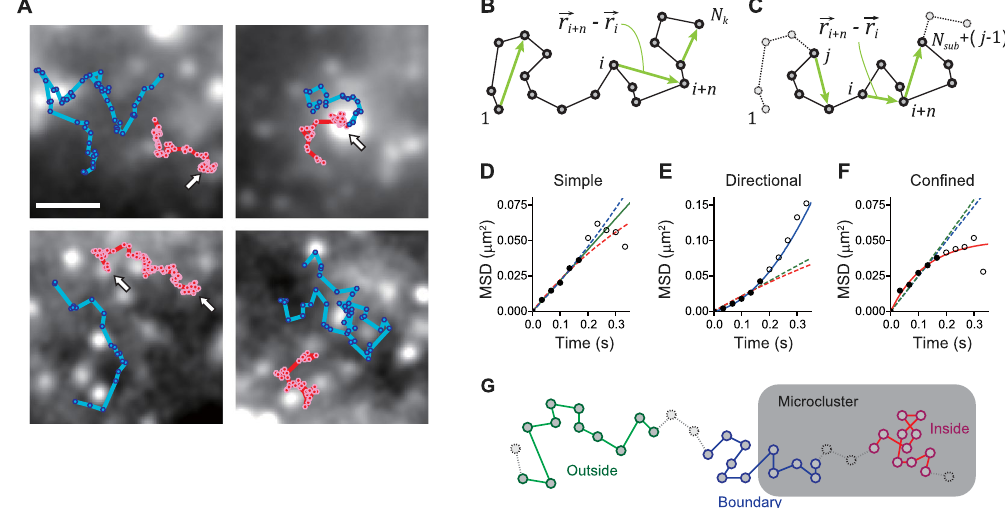
Figure 3. Schematic representation of moving subtrajectory analysis and kinetics analysis. ( A ) Shown is a gallery of single-molecule trajectories of Qdot 585-labeled CD45 (cyan) and Qdot 655-labeled CD3 ε (red) superimposed upon 200-frame averaged CD3 ζ -EGFP images, which were obtained by analysis of simultaneous triple-color single-molecule movies recorded at 33.33 ms/frame. Arrows indicate trajectories inside TCR microclusters. Bar, 1 μ m. ( B ) Standard MSD analysis using single-molecule tracking. ( C ) Moving subtrajectory MSD analysis. All subtrajectories were composed of successive N sub spots ( N sub = 11 in the present study), i.e., ( N sub − 1) steps were extracted from each trajectory, and their MSD curves were calculated. ( D–F ) Representative examples of sorting of the subtrajectories into the three diffusion types: simple ( D ), directional ( E ), and confined ( F ). After each subtrajectory was fitted to all three equations for the simple (Equation 5, green), directional (Equation 6, blue), and confined (Equation 7, red) diffusion, it was assigned to the diffusion type giving the least residual standard error of the fitting (solid line: assigned, dashed line: not assigned). Within 10 data points of the MSD of a single subtrajectory, the first 5 points (filled circle) were used for the fitting and the later points (open circle) were not. ( G ) Schematic representation of sorting of the subtrajectories of a trajectory into the three location groups: the inside (red), boundary (blue), and outside (green) of the